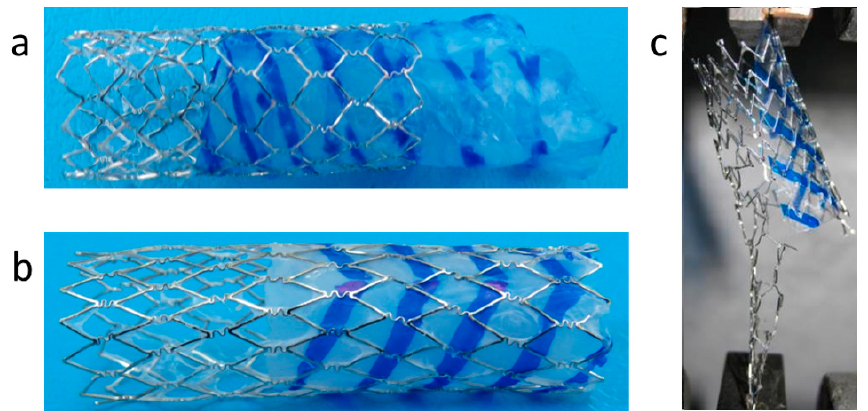
Figure 9. In vitro test of welding strength: ( a ) Image of the sleeve welded to the coated stent, using CLUR4K; ( b ) The sleeve after the pull-out test. ( c ) Pull out test of a PTUR650 patch welded to the covered stent.